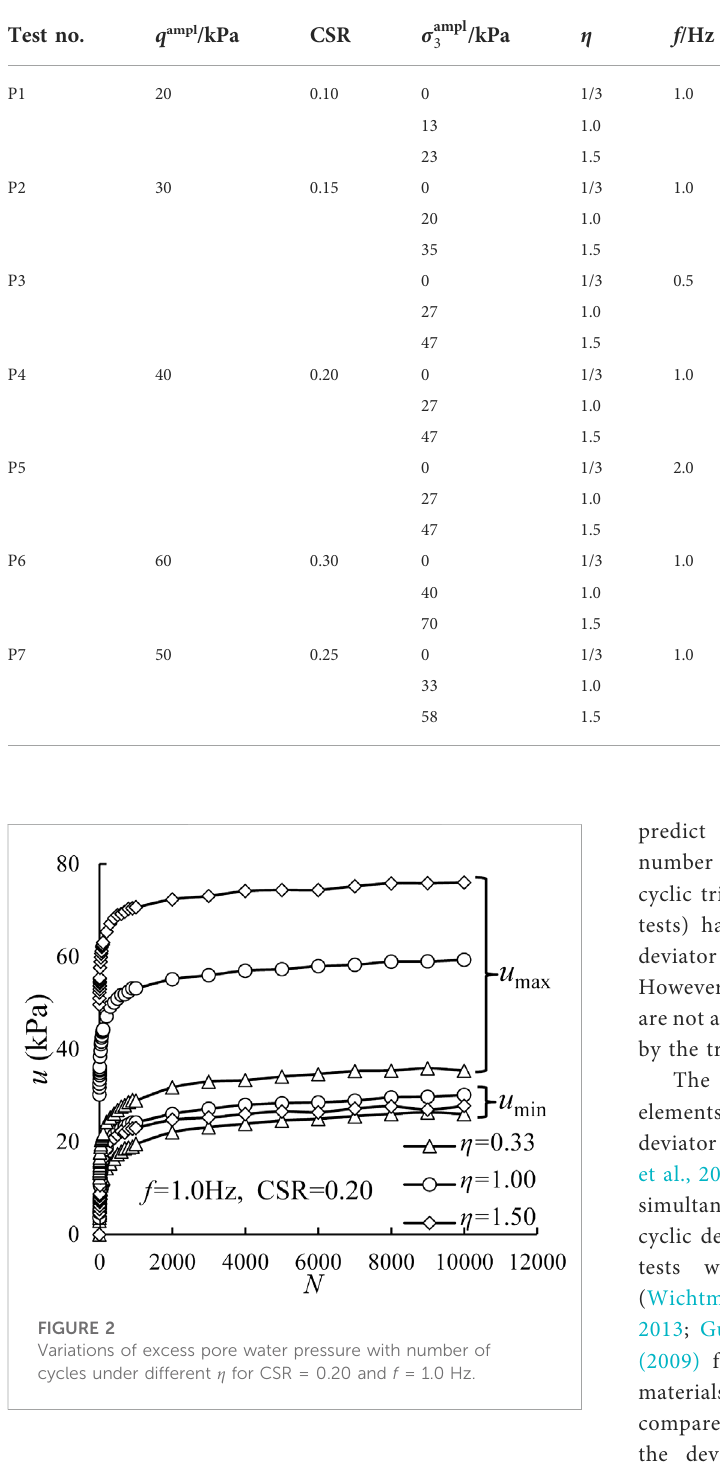
TABLE 2 Summary of cyclic triaxial tests.